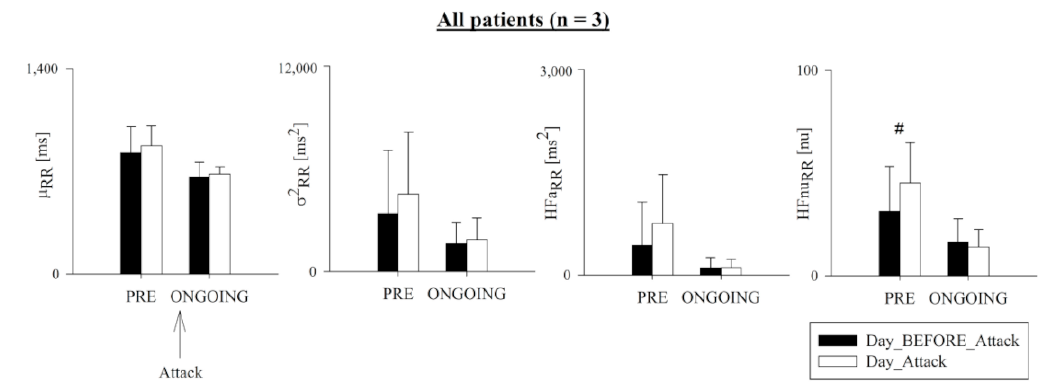
Figure 1. Pooled time- and frequency-domain heart-rate variability (HRV) markers in all patients (n = 3). Bar graphs show RR mean ( µ RR ), RR variance ( σ 2 RR ), and the absolute (HFa RR ) and normalized (HFnu RR ) power in the high-frequency (HF) band. Data in the 4 h preceding (PRE) and the first 4 h following the onset of the hereditary angioedema (HAE) attack (ONGOING) were pooled together on the day of the attack (Day_Attack, white bars) and compared with data during the same phase of the circadian rhythm on the day before (Day_BEFORE_Attack, black bars). Data are relevant to all patients and presented as mean ± standard deviation. Symbol # indicates p < 0.05 Day_Attack vs. Day_BEFORE_Attack.